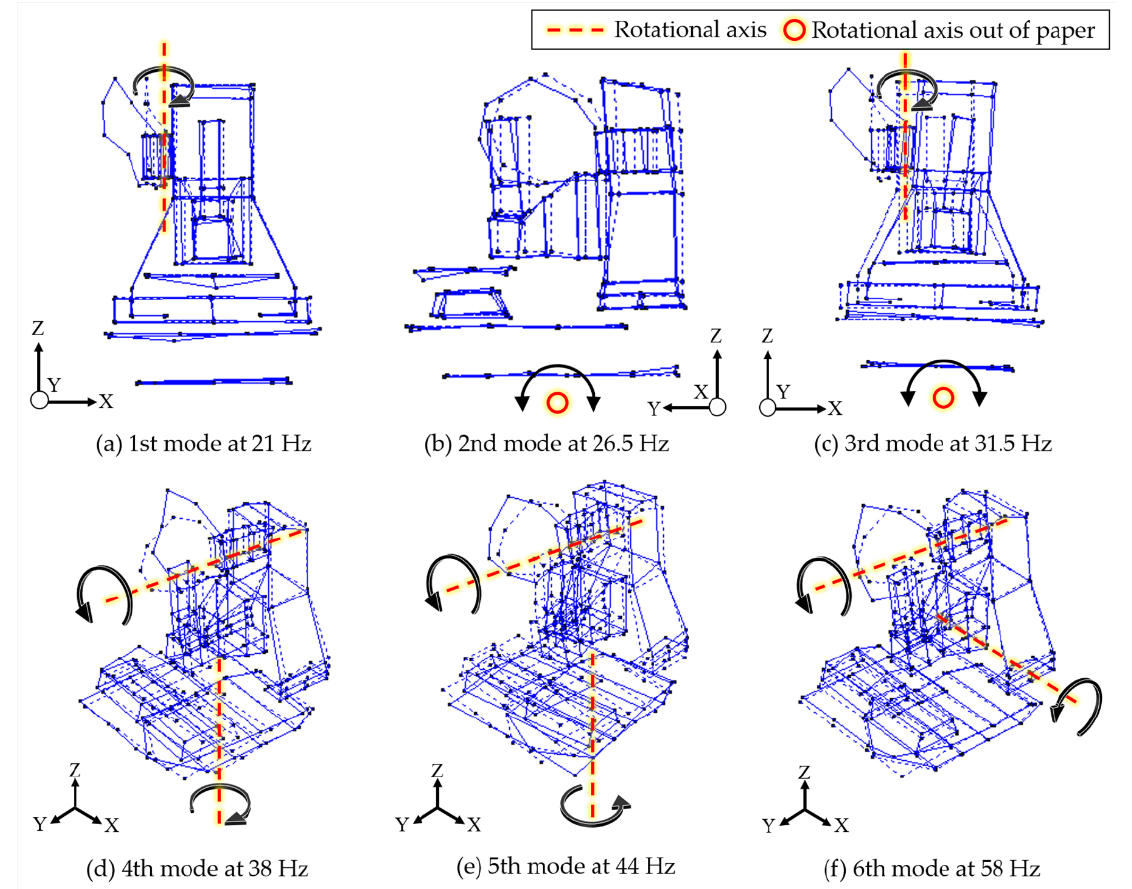
Figure 11. Experimental with the first six natural frequencies and mode shapes.